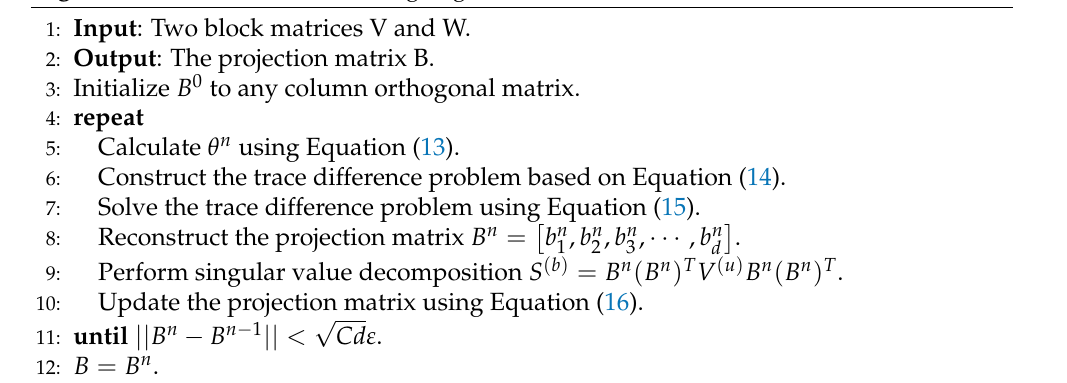
Algorithm 1 Multi-modal Learning